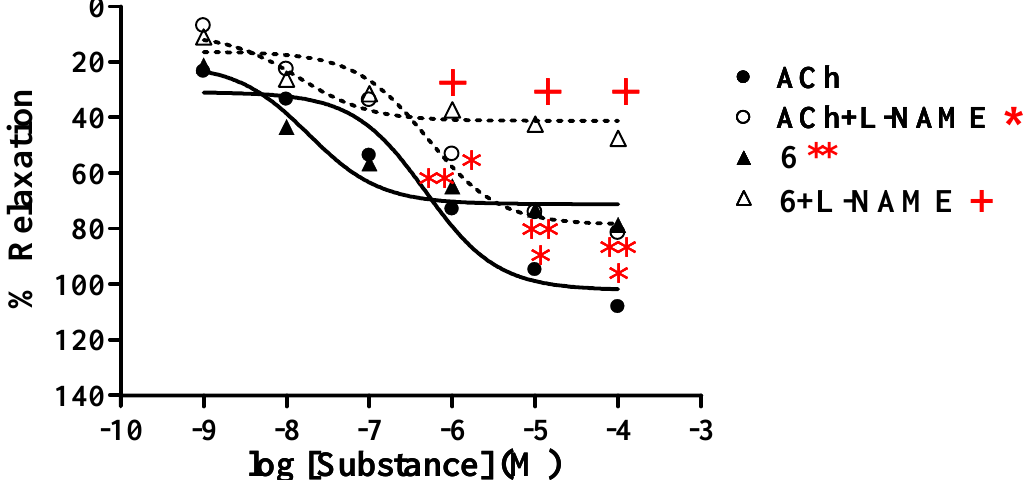
Figure 3. Effect of 6 on the vascular function of rat thoracic aorta in the presence of L -NAME (1 mM) compared with ACh.